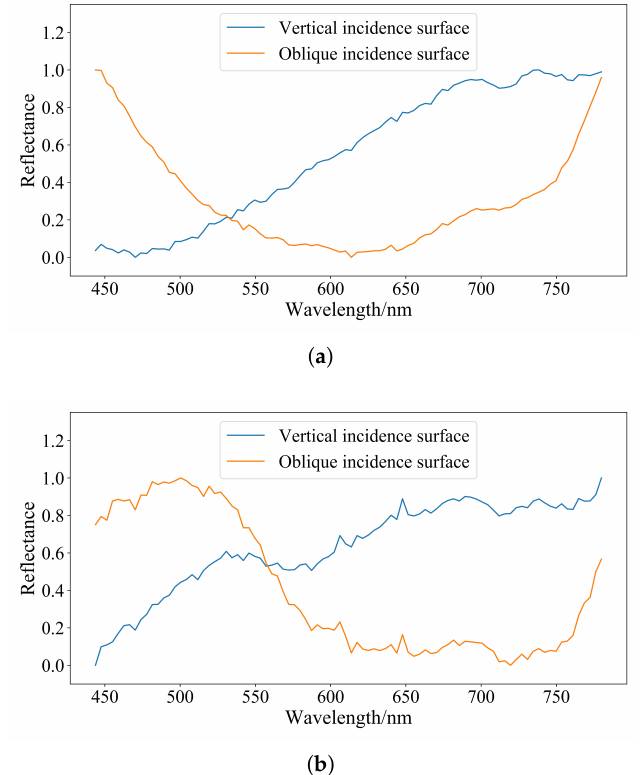
Figure 5. Normalized spectra of gold mylar in the images with different illumination conditions: ( a ) the first image; ( b ) the second